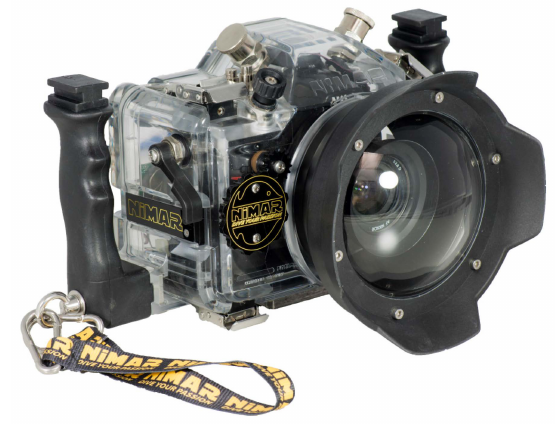
Figure 7. NiMAR NI320 dome port and NI303D waterproof